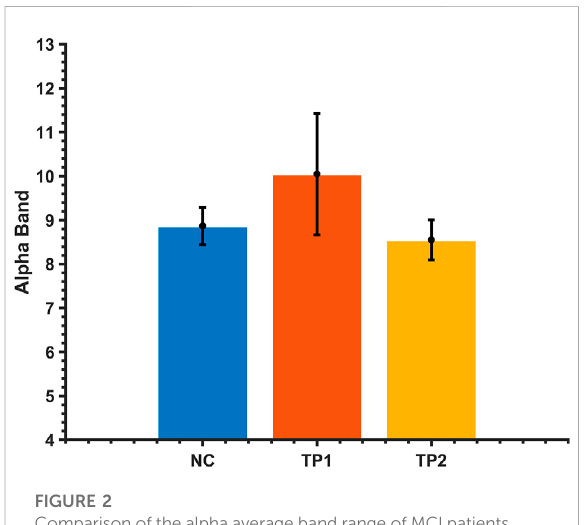
FIGURE 2 Comparison of the alpha average band range of MCI patients and normal controls before and after the dual-target rTMS intervention. The vertical axis is the frequency of the alpha band.